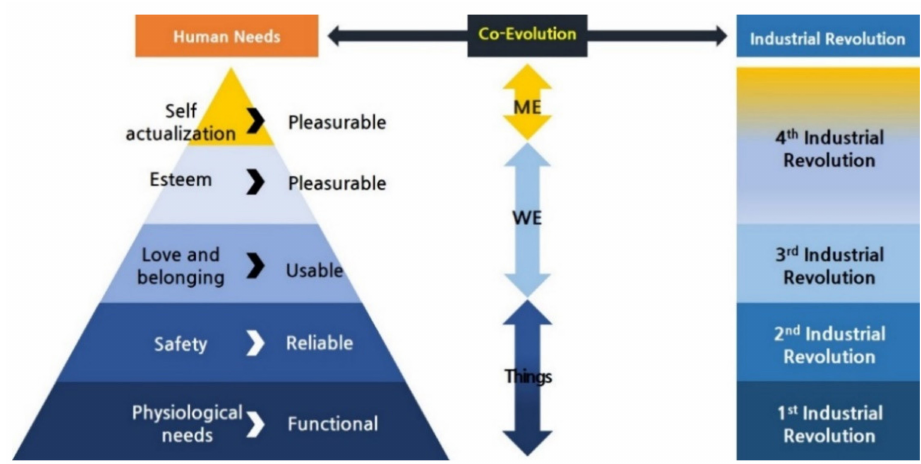
Figure 1. Relationship between hierarchy of human needs and the evolution of the Industrial